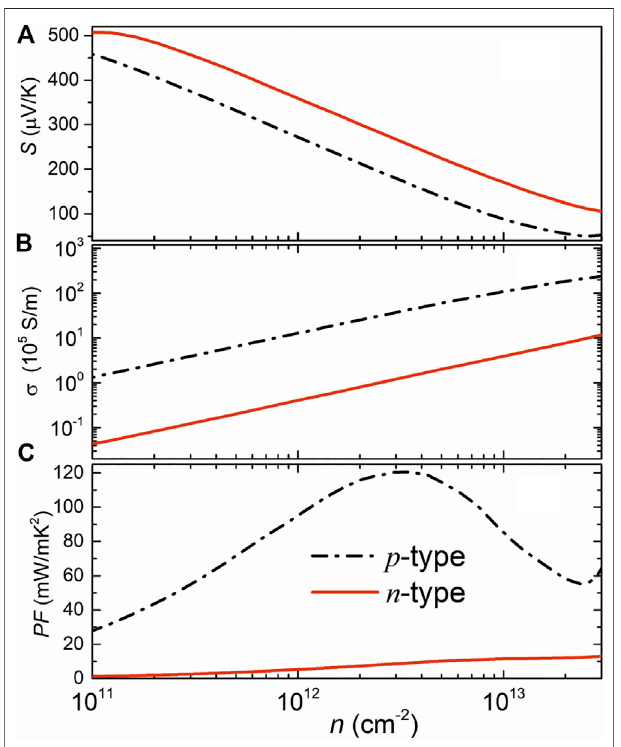
FIGURE 2 | Calculated Seebeck coef fi cient (A) , electrical conductivity (B) , and the power factor (C) of the β s 1 boron monolayer at 300 K.